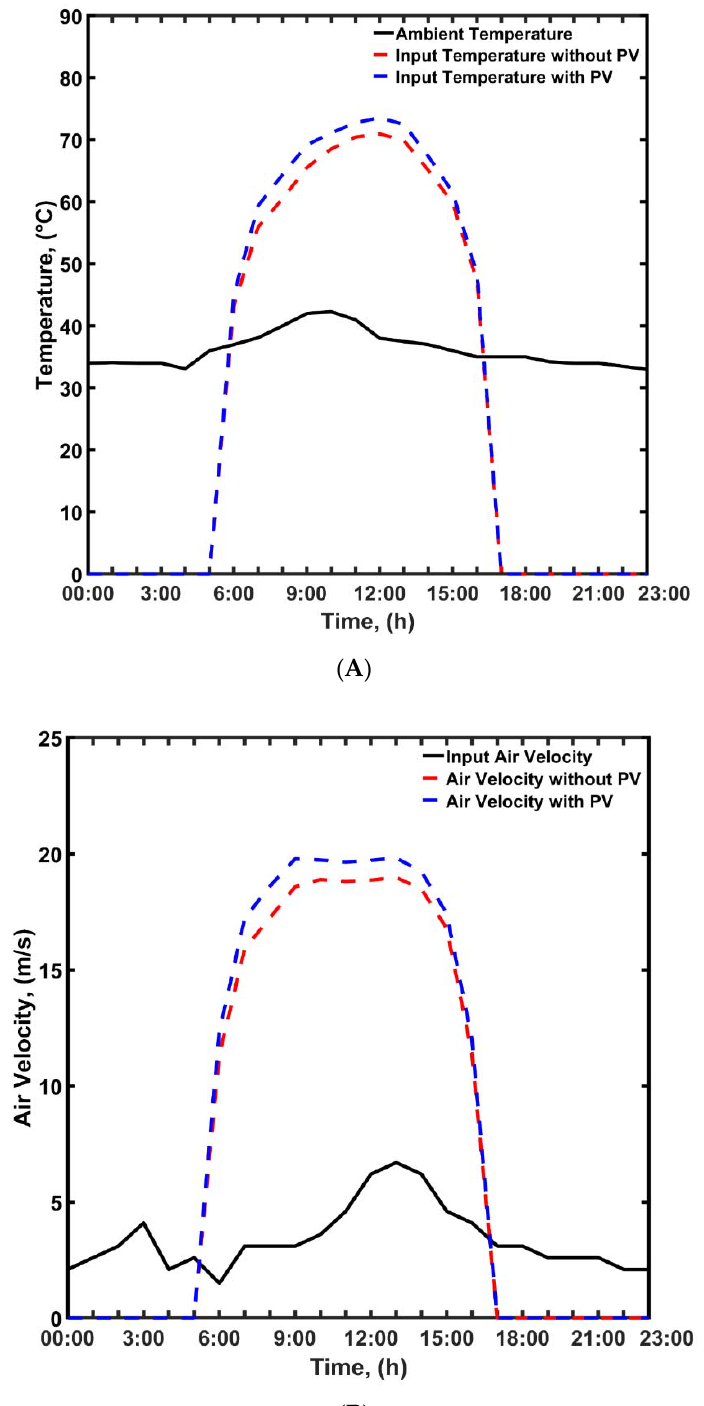
Figure 6. ( A )The temperature profile of air before entering the turbine for SCPP and PV-SCPP system; ( B ) the air velocity profile air before entering the turbine for SCPP and PV-SCPP